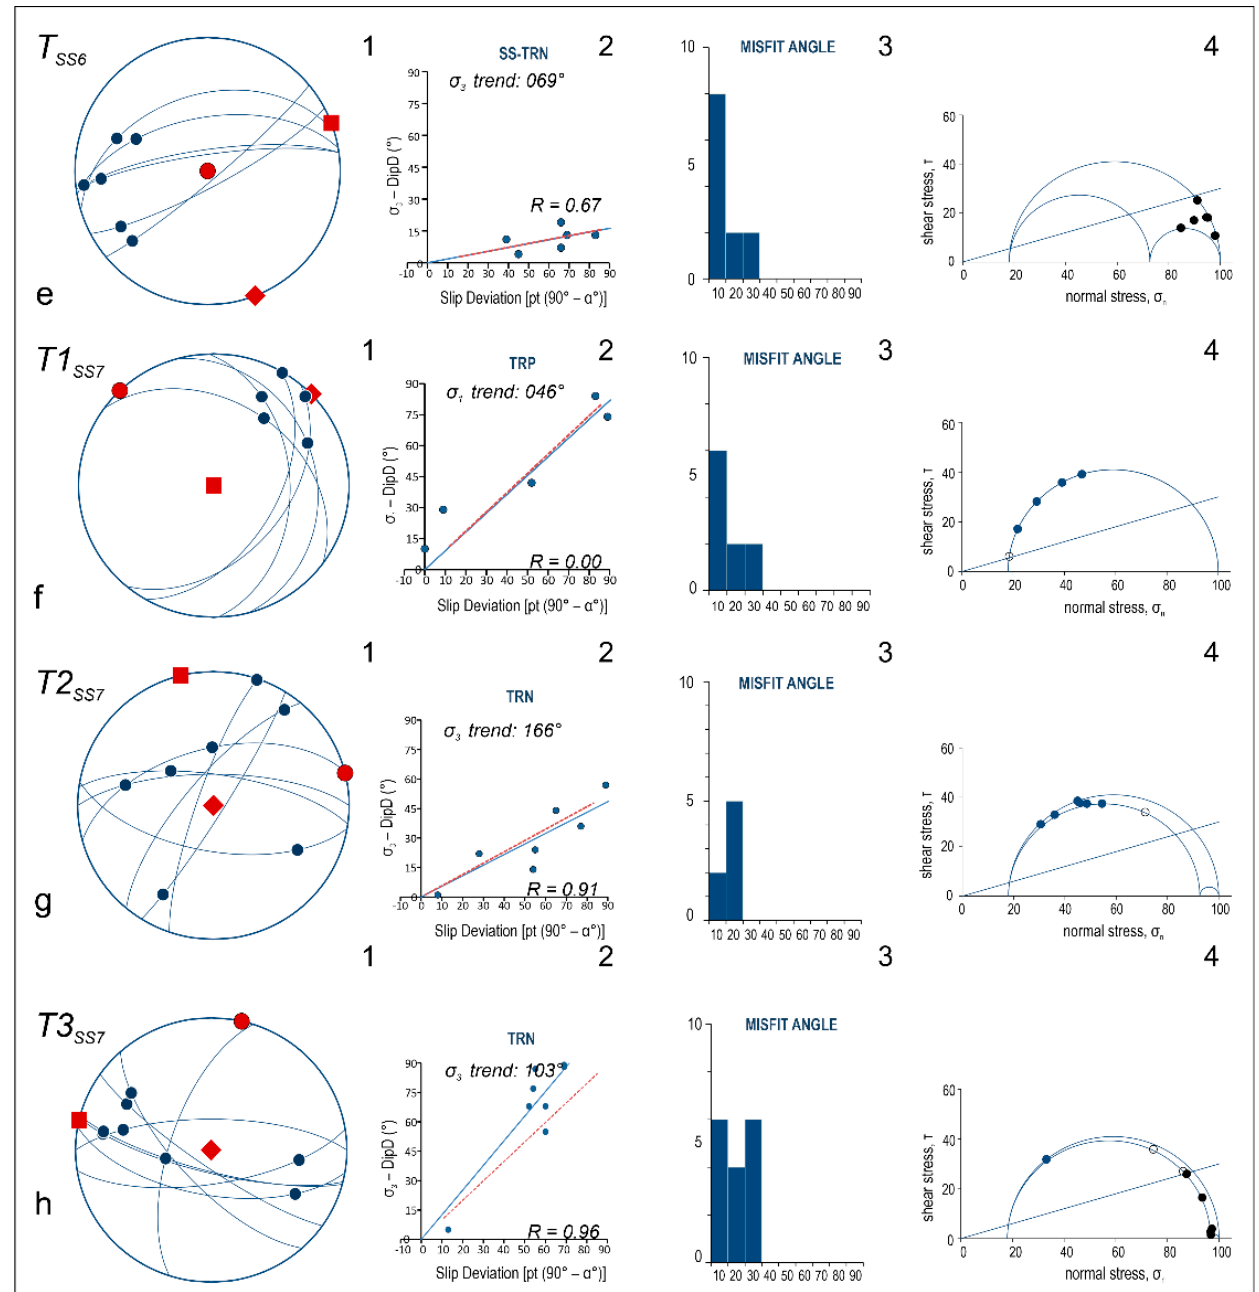
Figure 2. The TRM application [44] to the fault-slip data presented at the different SSs by [32]. The optimal resolved enhanced Andersonian stress tensors ( σ 1 : solid rhomb, σ 2 : solid circle, and σ 3 : solid square) ( a ) T SS2 , ( b ) T1 SS3 , ( c ) T2 SS3 , ( d ) T3 SS3 , ( e T SS2 , ( f T1 SS7 , ( g ) T2 SS7 , and ( h ) T3 SS7 with Misfit Angle (MA) ≤ 30 ◦ . Explanation: 1. Stereographic projection (equal-area, lower hemisphere) of the TR compatible fault-slip data (TRCF), the blue balls are extensional faults in the extensional stress regimes and contractional faults in the compressional stress regimes; 2. TR diagram shows the TRCF (solid blue balls), the ‘real’ (blue colored line), and ‘theoretical’ (red dashed line) Final Tensor Ratio Line (FTRL); 3. Misfit Angle (MA) distribution of the TRCF; 4. Mohr diagram of the TRCF. Solid blue balls show the TRCF having T s ≥ 0.6. Open balls show the TRCF with T s < 0.6. The blue line shows the lowest initial friction curve at the frictional angle φ = 16.7°.